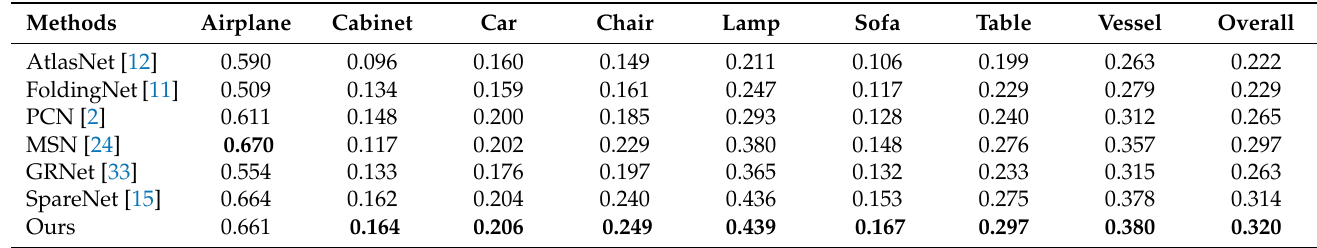
Table 4. Point completion results on PCN in F-score @1% (higher is